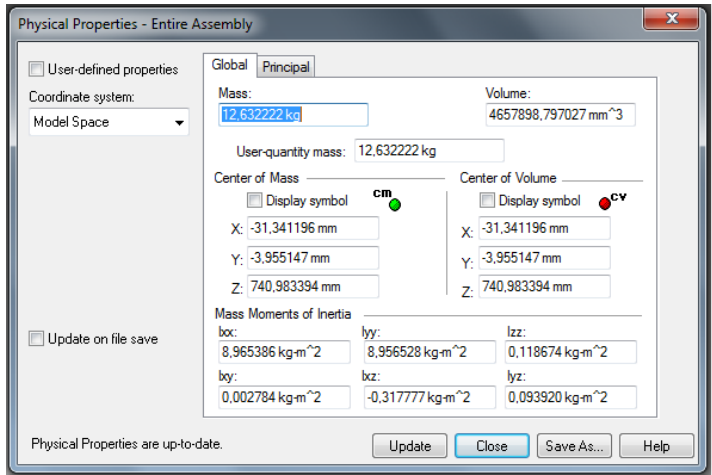
Figure 3. Physical properties of the manipulator joint 2—Software Solid Edge c (cid:13) .